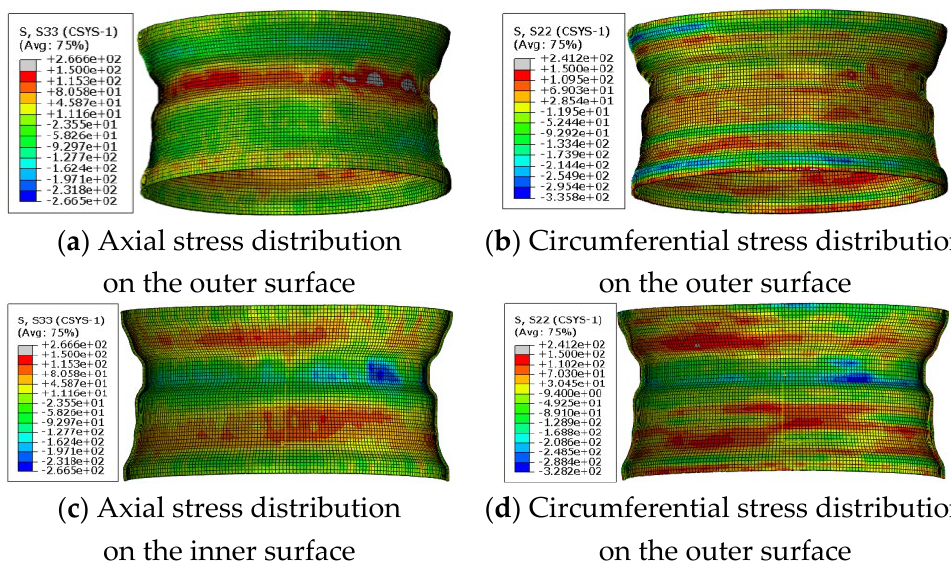
Figure 3. Residual stress distribution after the first rolling.